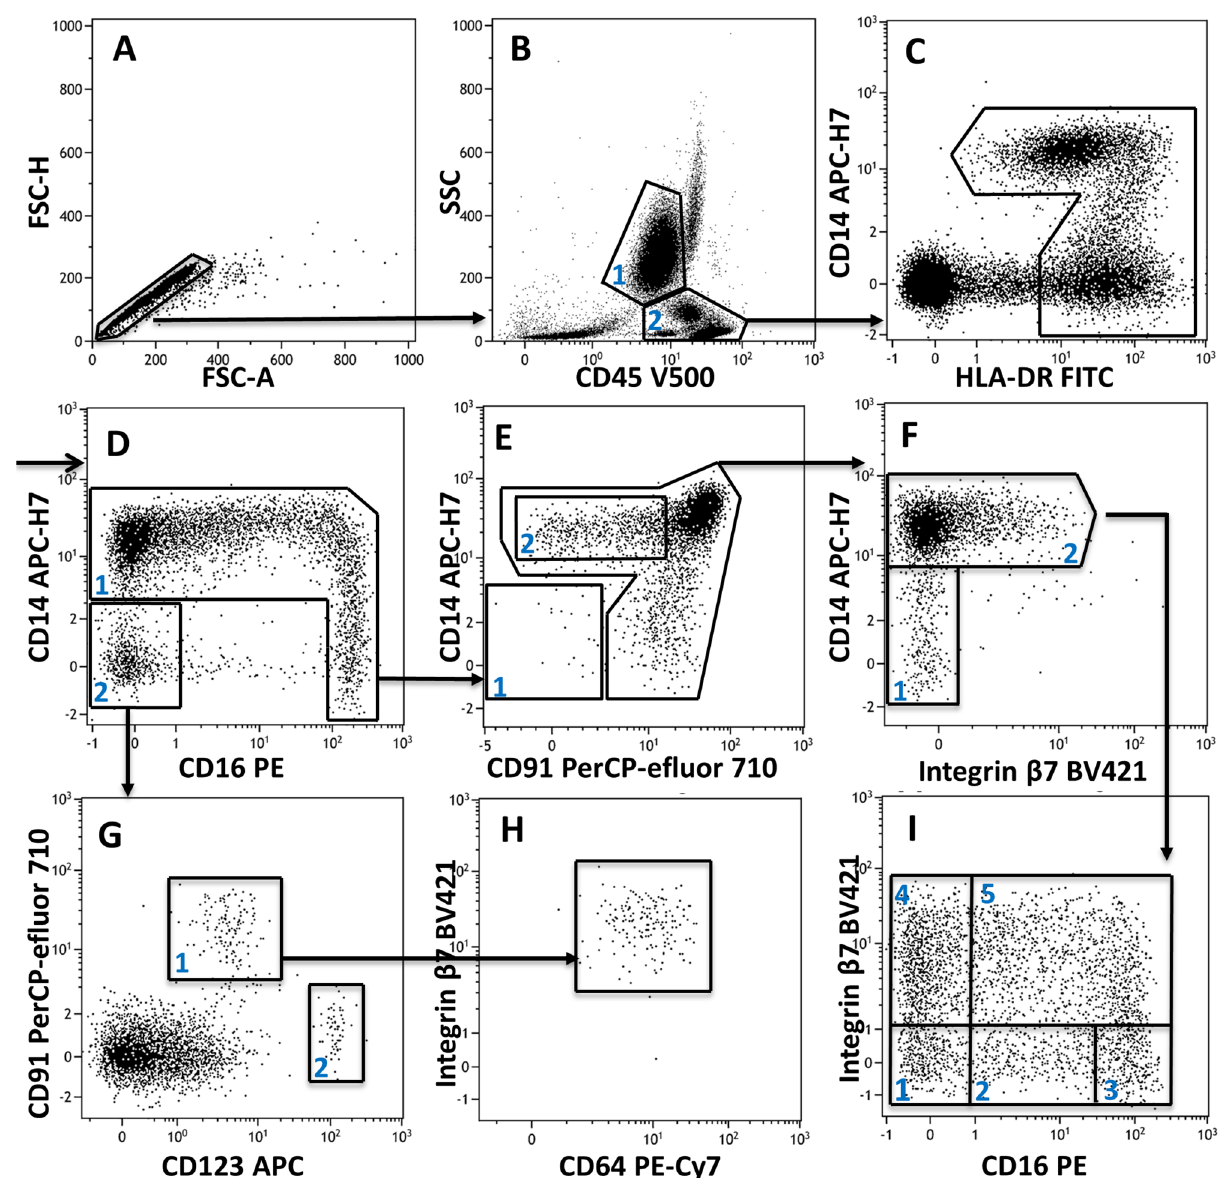
Figure 1. Sequential gating was used to isolate 7 distinct monocyte and 2 dendritic cell subsets (explanations in the text). The example shown is from a cardiac surgery patient 24 h